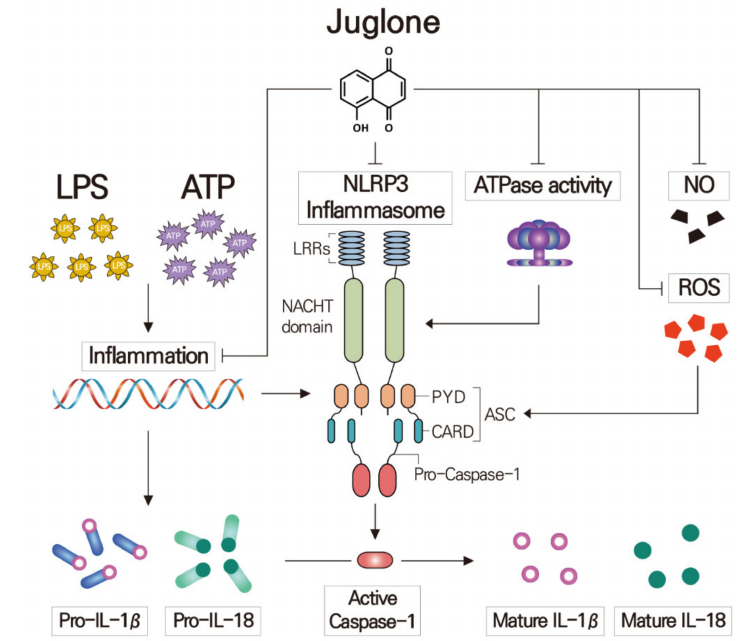
Figure 6. Proposed mechanism underlying the anti-inflammatory e ff ects of juglone in macrophages. Pre-treatment of macrophages with juglone suppressed ATP-induced IL-1 β , IL-18 and NLRP3 secretion in LPS-primed J774.1 mouse macrophages. Juglone also caused downregulation of ATPase activity and ROS and NO production. Juglone also reduced the mRNA expression and activation of IL-1 β , IL-18, NLRP3 and caspase-1. The results show that juglone inhibits IL-1 β and IL-18 secretion and NLRP3 formation in activated